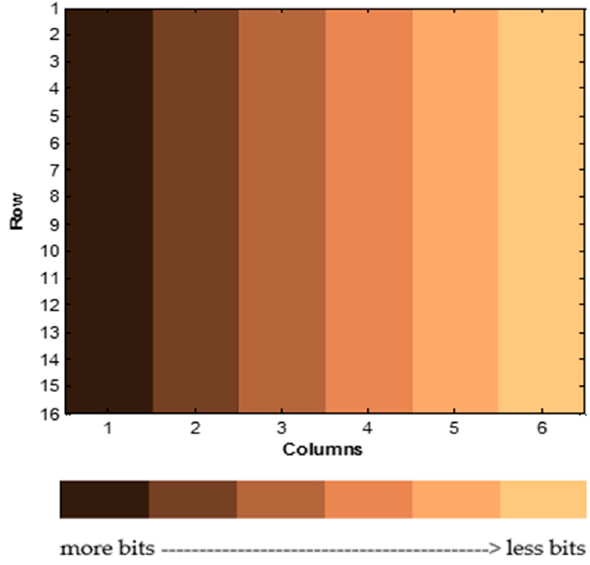
Figure 9. Bits allocation for reduced-dimensional matrix (darker color means more bits needed).